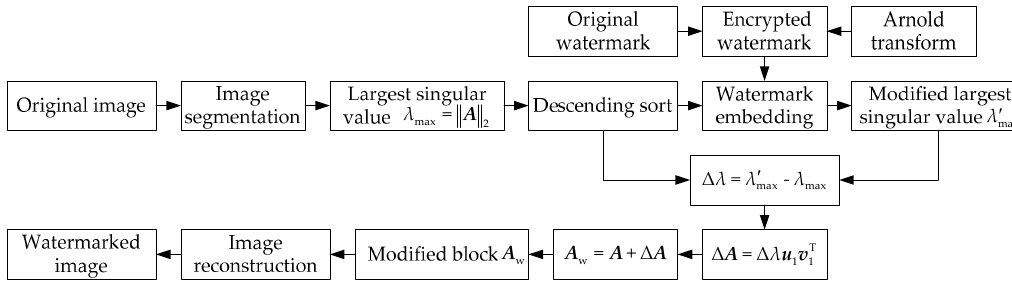
Figure 3. Watermark embedding process.